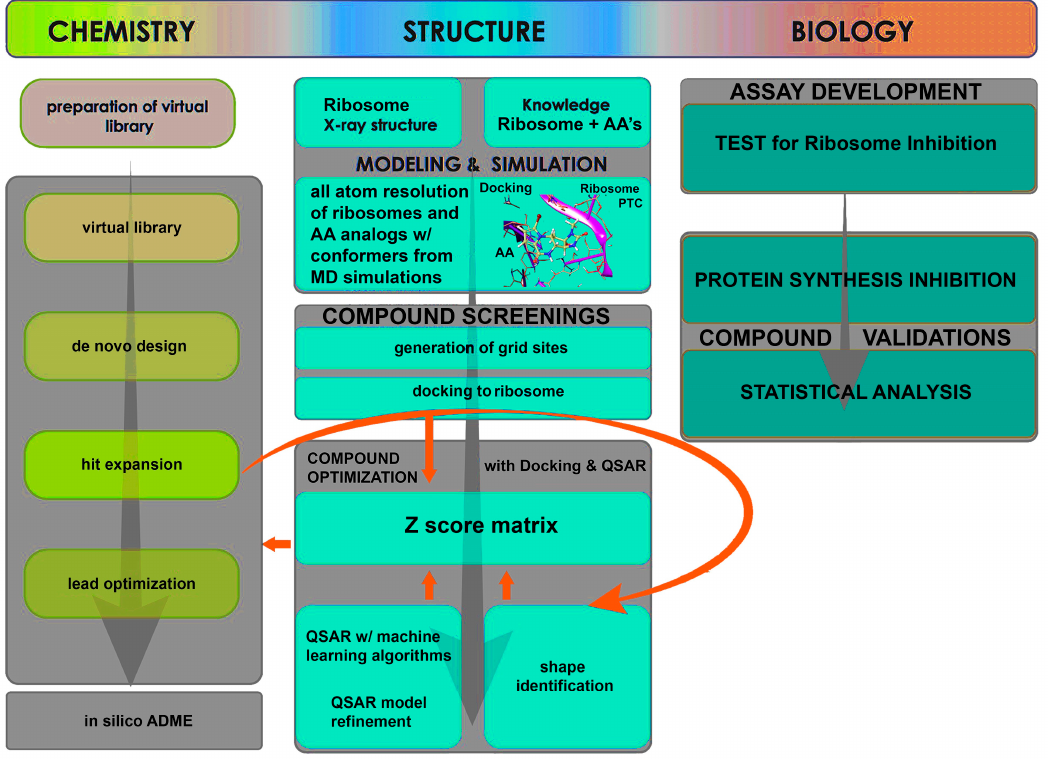
Figure 2. Flow-diagram of virtual screening protocol for ribosome interrogation with AA and AA analogs. Chemistry to Structure studies to Biological validation scheme is shown. The left-most column contains all the chemistry protocols for preparing the AA compound library for virtual screening in a structure-based drug discovery approach that relies on docking. The central column describes the various components that are required for docking the compounds with the X-ray structure for the ribosome and how it is scored for validation with the Biological testing. The right-most column indicates all of the biological assays and screening completed for assessment of AA and AA analogs effect on ribosome inhibition within cells.